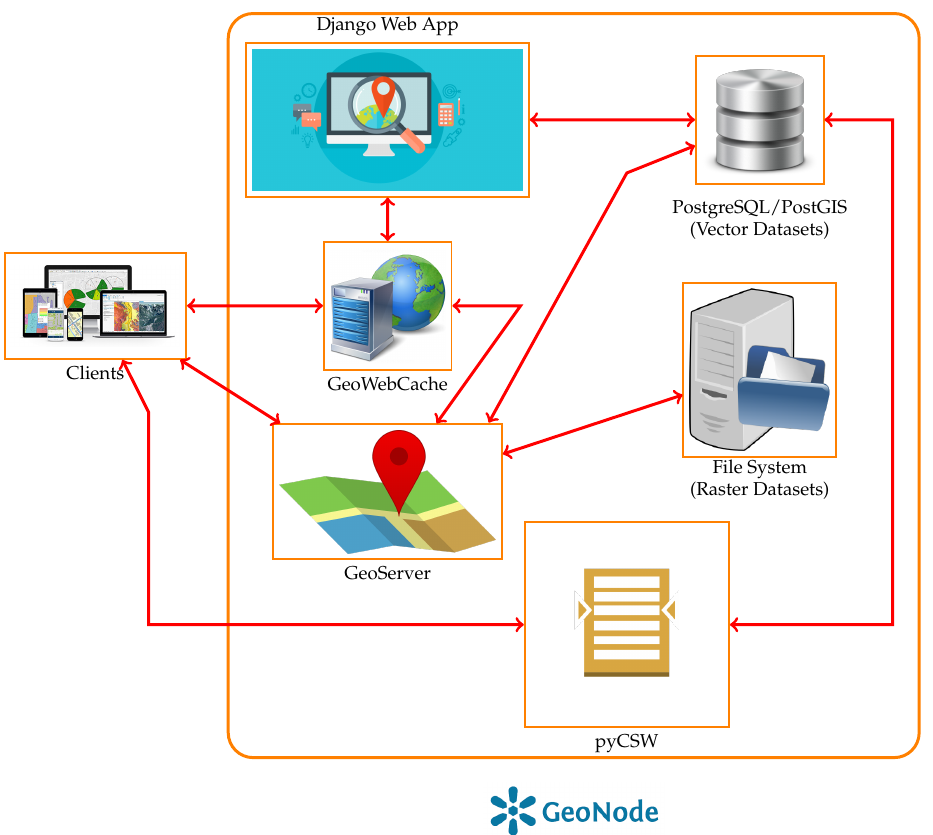
Figure 4. Flow chart of the GeoNode core components